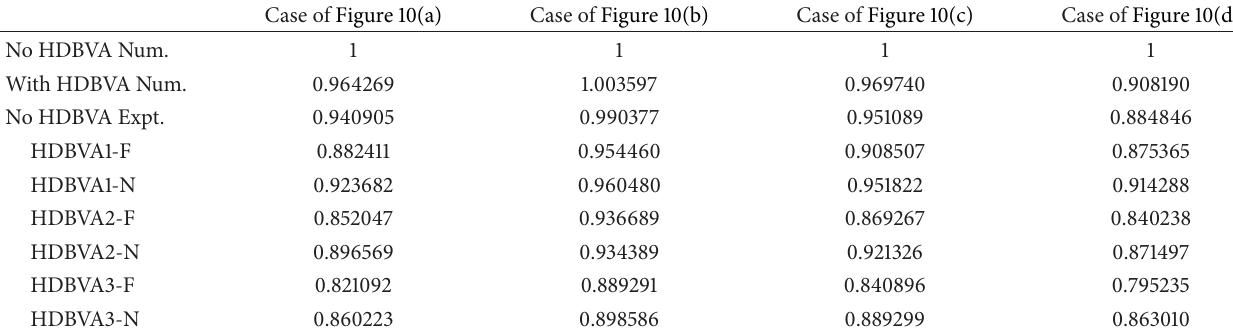
Table 3: Damping effects of groove and slider combinations (normalized).